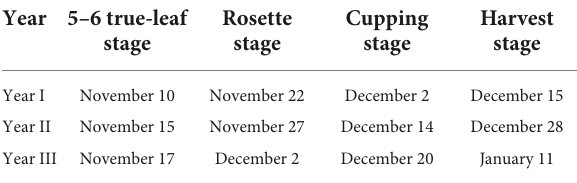
TABLE 2 Sensing dates of bok choy at the four specific growth